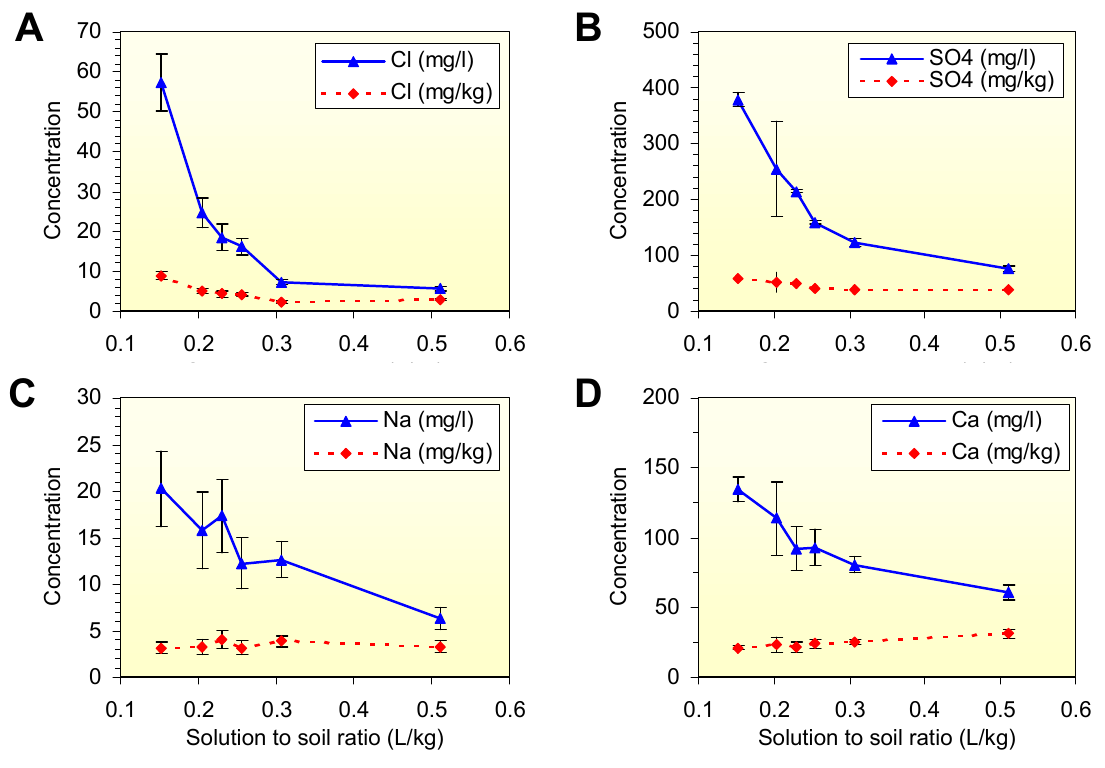
FIGURE 1 . Concentrations in aqueous extracts (solid lines) and extracted amounts (dotted lines) of Cl (cid:150) , SO 42(cid:150) , Na, and Ca as a function of extraction ratio. Error bars denote the standard deviation ( n = 3). RESULTS AND DISCUSSION